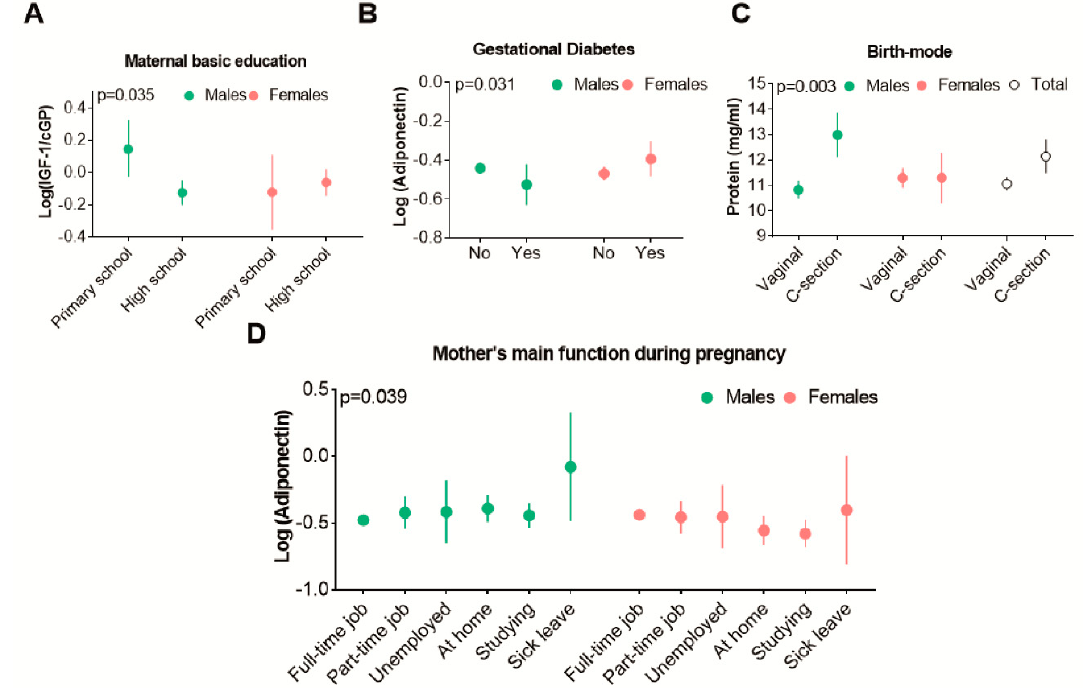
Figure 2. Sex-specific interactions and human milk (HM) composition. p -values are relative to the interaction between the two factors and HM composition (i.e., infant sex, birth-mode and milk protein). All the graphs show that maternal factors (( A ) basic education, ( B ) gestational diabetes, ( C ) birth-mode and ( D ) mother’s occupation during pregnancy) is associated with the concentration of HM components in a sex-specific manner. Graphs represent Mean and CIs. Mothers in the Sick Leave group were only n = 3 (two males and one female). IGF1 = Insulin-like growth factor 1, cGP = cyclic-Glycine-Proline, IGF1cGP = IGF1/cGP ratio.